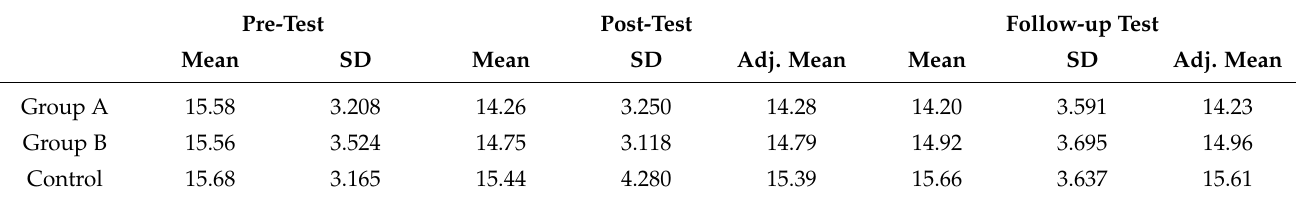
Table 1. Mean and SD of the three conditions at the three-time periods for CES-D